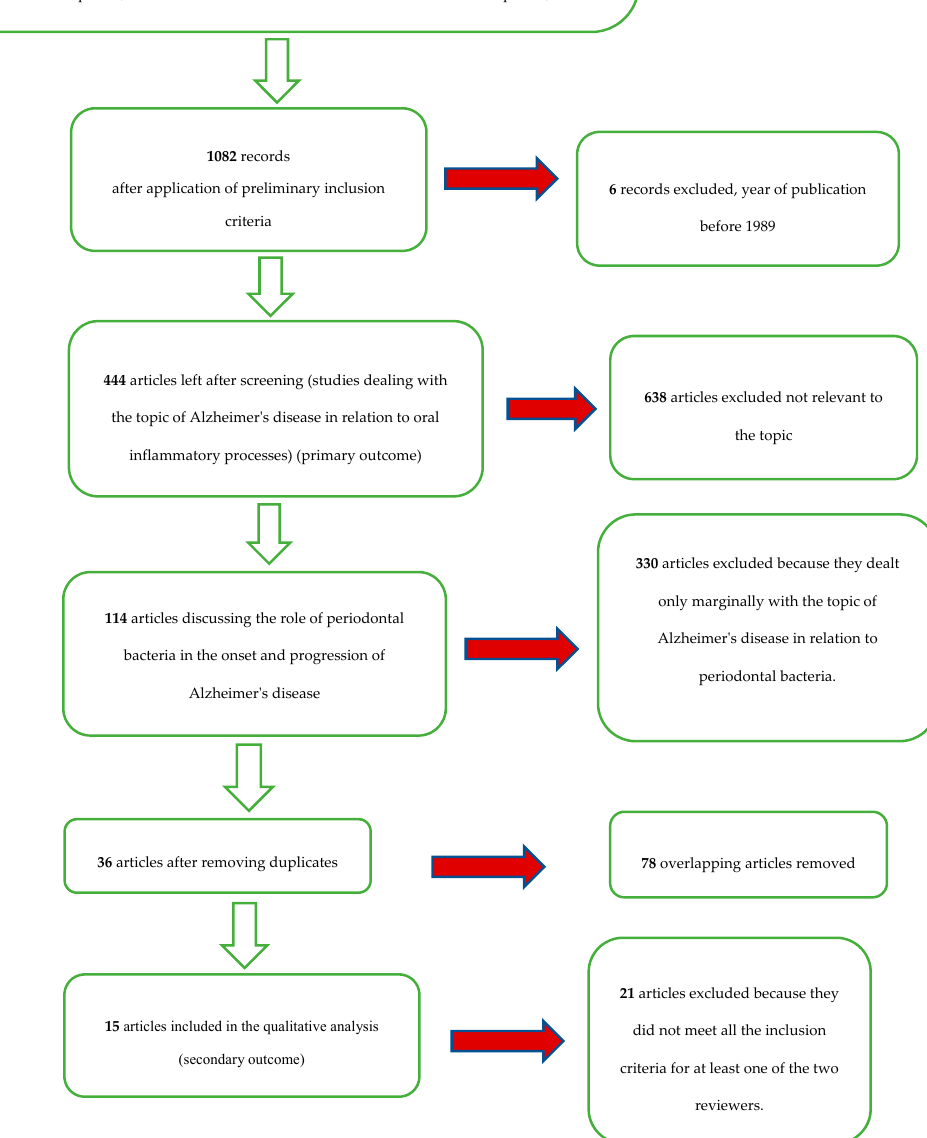
Figure 1. Flowchart of the different phases of the systematic review. The data extracted for the secondary outcomes are shown in Table